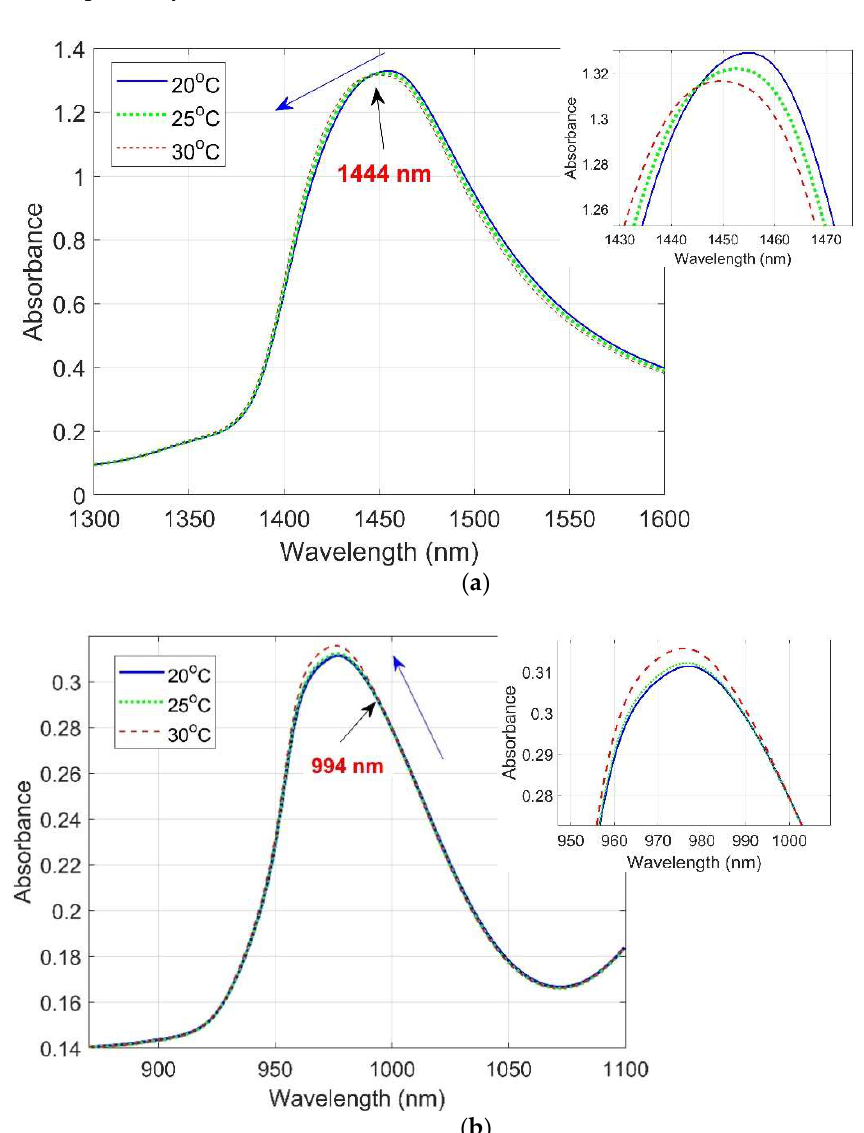
Figure 3. Average raw absorbance spectra of kiwifruit juice at three temperatures 20, 25, and 30 °C in ( a ) the first overtone and ( b ) the second overtone region of the OH stretch of water. Labels indicate wavelengths of the isosbestic points.